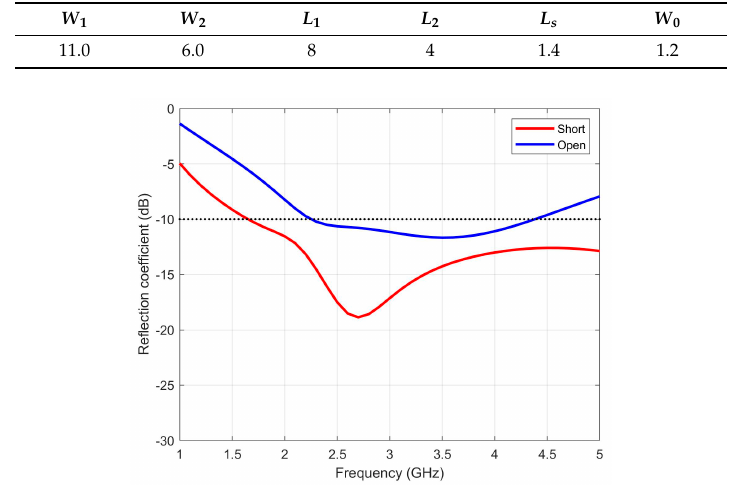
Figure 3. Simulated reflection coefficients of the asymmetric Jerusalem cross slot antenna. Table 2. Dielectric properties of the tissues [18].